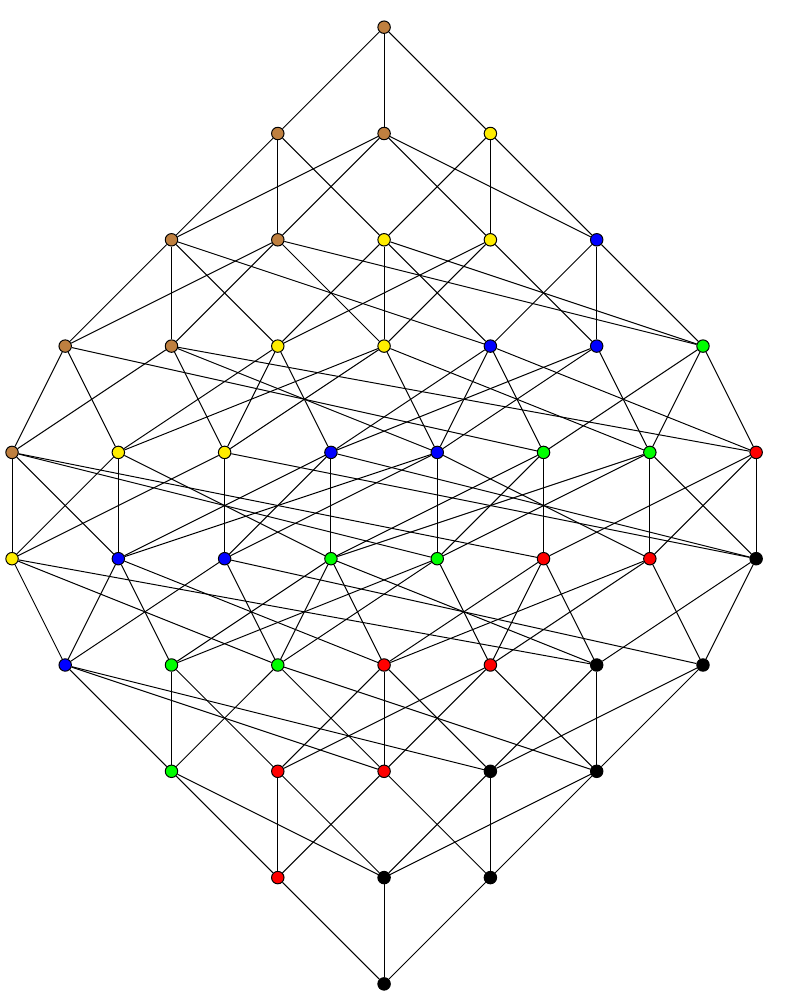
Figure 4 . The Bruhat order for B 3 . As in (cid:12)gure 2, we use the same color for elements of W that contribute to the same module M c (see section 5). The compact subgroup W J is isomorphic to the Weyl group of B 2 , and one can check that the subset of elements in each given color is isomorphic to (cid:12)gure